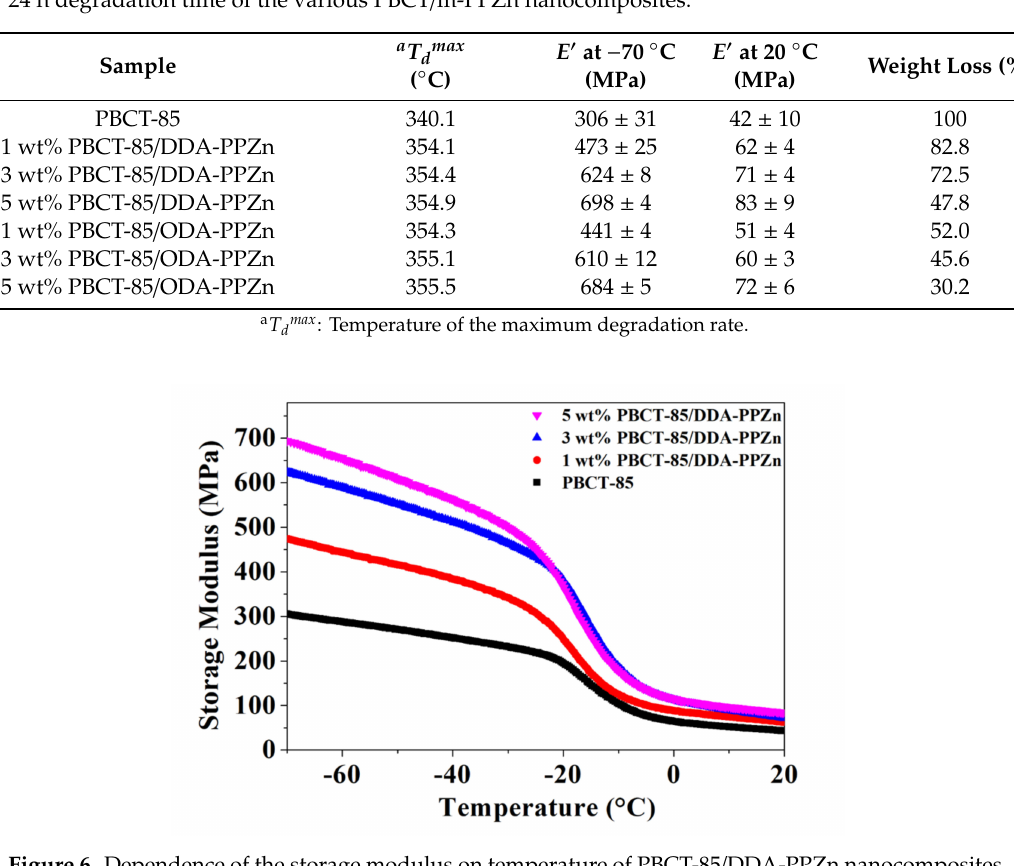
Figure 6. Dependence of the storage modulus on temperature of PBCT-85 / DDA-PPZn